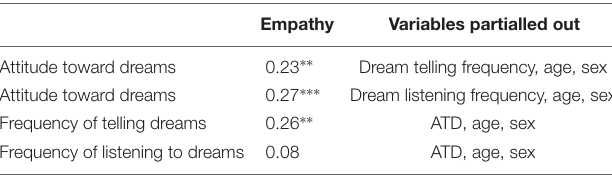
TABLE 4 | Pearson partial correlation co-efficients between trait empathy and dream variables, with age, sex, dream sharing and ATD variables partialled out, dfs =